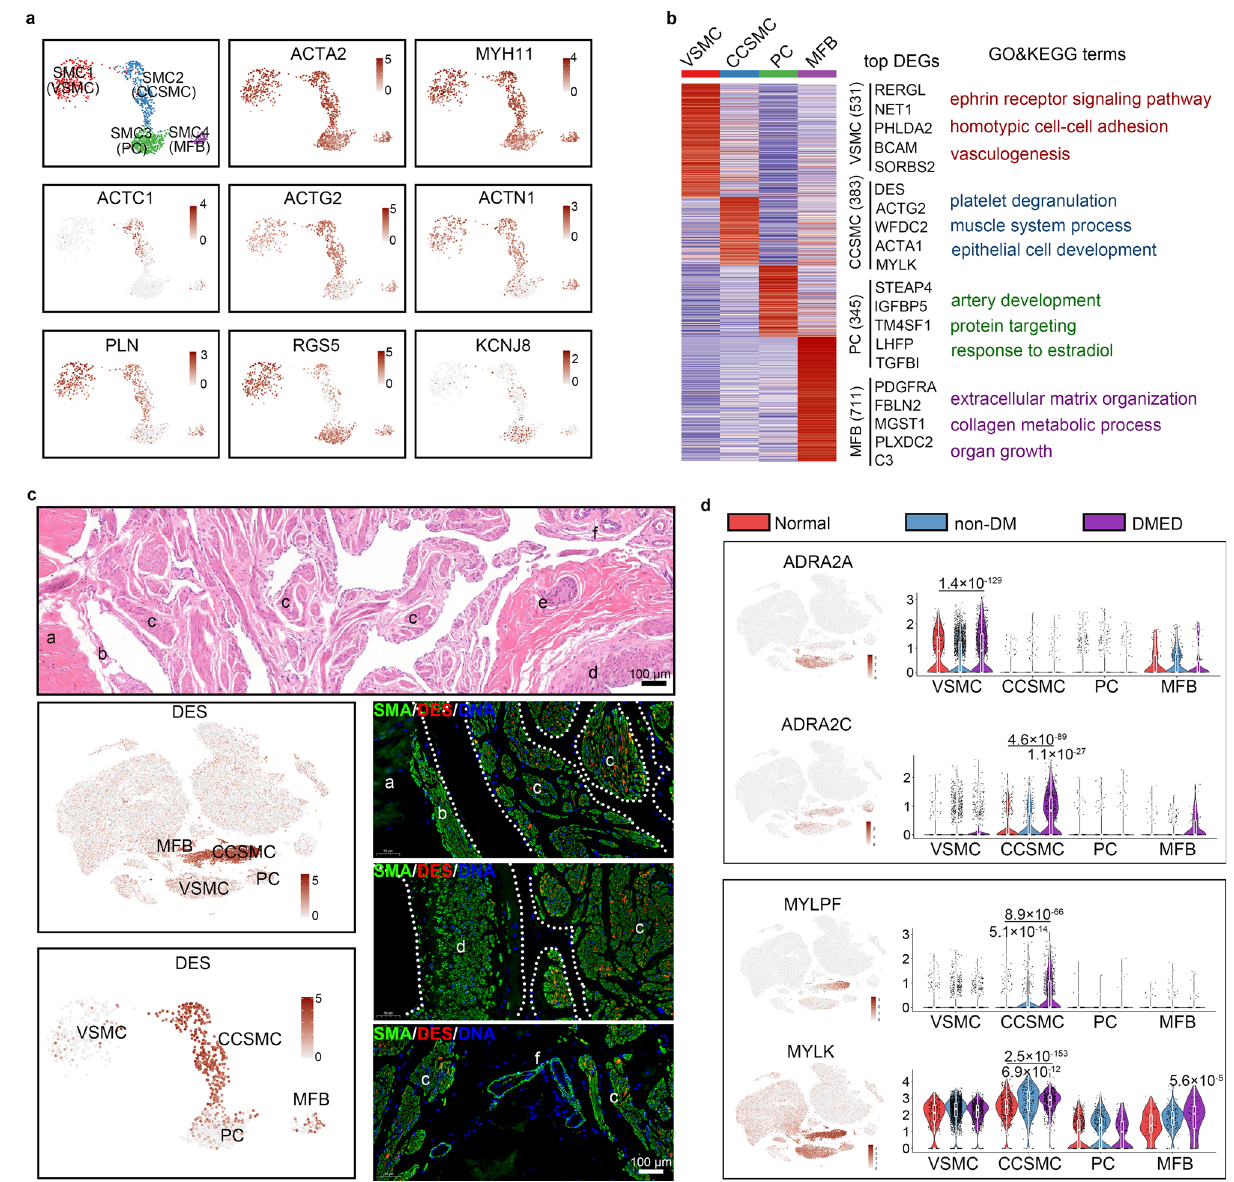
Fig. 4 | The heterogeneity within the SMC cluster. a tSNE plots of the four SMC subclusters. The cells are coloured according to their subcluster or the expression level of classic actin and myosin genes. VSMC: vascular smooth muscle cells; CCSMC: corpus cavernosal trabecular smooth muscle cells; PC: pericyte; MFB: myo fi broblast. b The DEGs in each SMC subcluster (left panel) based on normal samples are shown as a heatmap, and the GO terms (biological process) asso- ciated with their DEGs are listed in the right panel. The count of the DEGs for each SMC subcluster is listed in the middle panel. c CCSMC and VSMC could be dis- tinguished according to DES protein expression. H&E staining showing the main region of the CC (upper panel). tSNE plots showing that DES is speci fi cally expressed in the CCSMC subcluster (left panel). Immuno fl uorescence co-staining of DES (red) and SMA (green) in CC paraf fi n sections. The scale bar represents